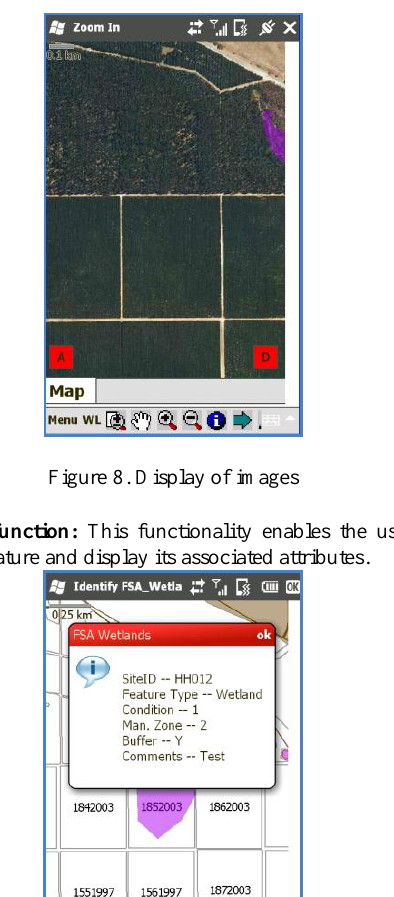
Figure 8. Mapping of wetland boundaries